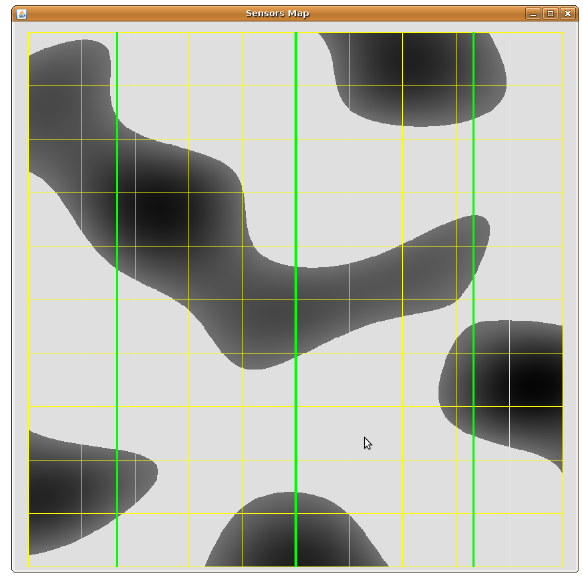
Figure 5. Synthetic outdoor scenario for the numerical tests. The green lines represent power